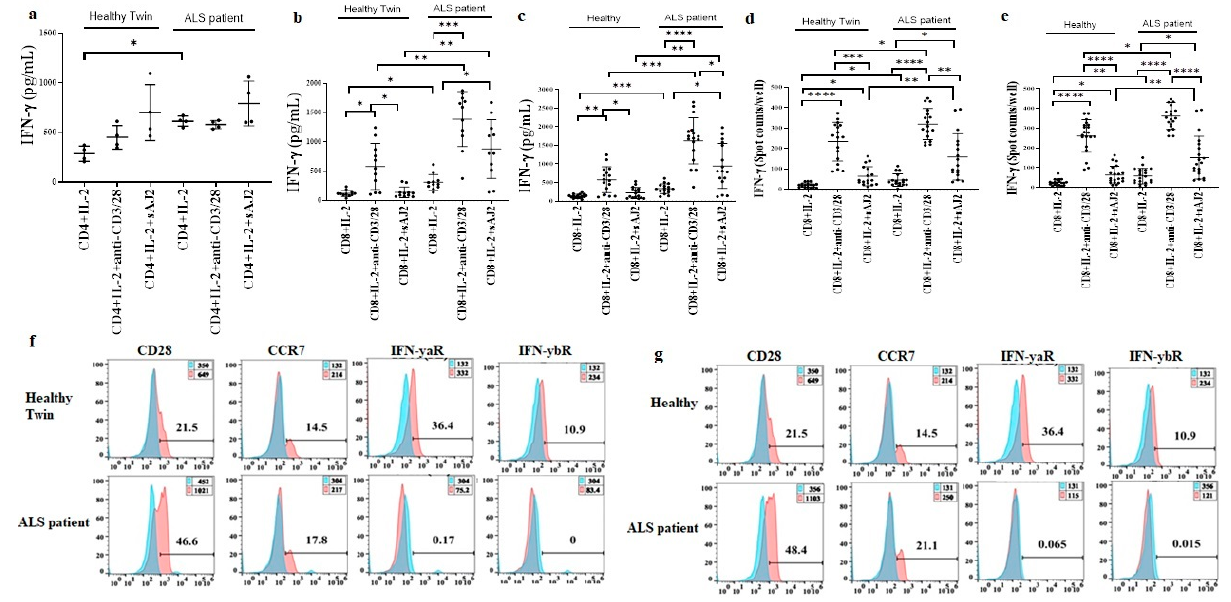
Figure 4. Increased effector memory and secretion of IFN- γ by CD8+ T cells from ALS patients in comparison to healthy individuals. CD4+ and CD8+ T cells of healthy individuals and those from ALS patients were isolated from PBMCs as described in Section 2. CD4+T cells (1 × 10 6 cells/mL) were treated with IL-2 (100 U/mL) or with a combination of IL-2 (100 U/mL) and anti-CD3/28 anti- body (25 µL/mL) or IL-2 (100 U/mL) and sAJ2 (CD4+ T:sAJ2, 1:2) for 18 h before the supernatants were harvested to determine IFN- γ secretion using single ELISA ( a ( n = 4)). CD8+T cells (1 × 10 6 cells/mL) were treated with IL-2 (100 U/mL) or with a combination of IL-2 (100 U/mL) and anti- CD3/28 antibody (25 µL/mL) or IL-2 (100 U/mL) and sAJ2 (CD8+ T:sAJ2, 1:2) for 18 h before the supernatants were harvested to determine IFN- γ secretion using single ELISA ( b ( n = 11), c ( n = 17)). CD8+ T cells were treated as described in ( b ), 18–20 h of treatments, the number of cells secreting IFN- γ were determined as spot counts using ELISpot assay ( d ( n = 18), e ( n = 20)). CD8+ T cells of healthy individuals and ALS patients were isolated from PBMCs as described in Materials and Methods. Surface expression of CD28, CCR7, IFN- γα R, and IFN- γβ R on CD8+ T cells were analyzed using flow cytometry, IgG2 isotype control antibody was used as control ( f , g ). One of five repre- sentative experiments is shown in ( f , g ). **** ( p -value < 0.0001), *** ( p -value 0.0001–0.001), ** ( p -value 0.001–0.01), * ( p -value 0.01–0.05).